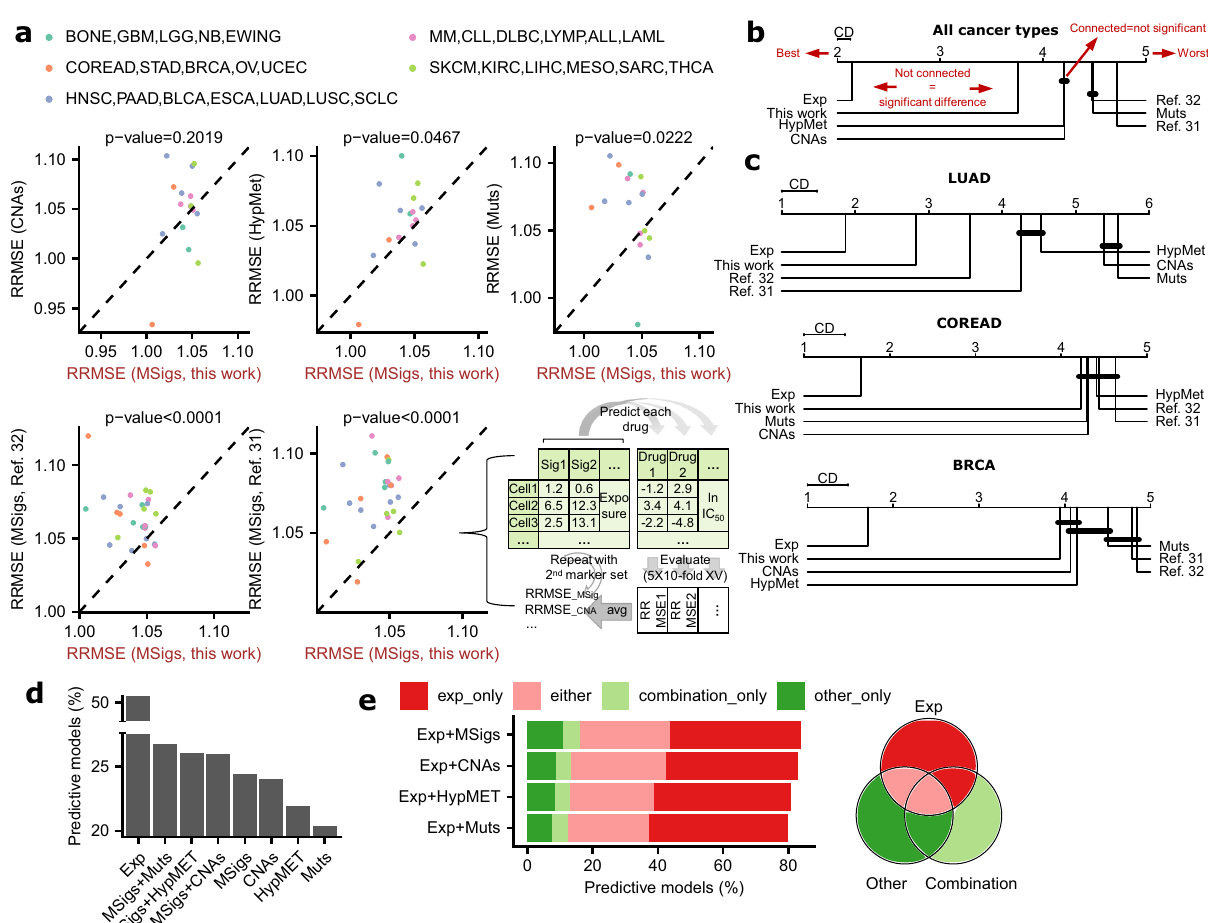
Fig. 2 Prediction of drug response with mutational signatures and other molecular data types. a Predictive performance (RRMSE, relative root-mean- square error) of drug response prediction with mutational signatures ( “ MSigs") reported here and previously 31,32 and other data types (oncogenic mutations ( “ Mut ” ), copy number alterations ( “ CNAs ” ) and DNA hypermethylation ( “ HypMet ” )). P-values of paired one-sided Wilcoxon signed rank test are reported on the plots. Dashed line denotes the diagonal. Bottom right panel shows a schematic of how RRMSE for each tissue was estimated, where “ Sig ” is mutational signature or other marker (CNA etc.), “ Cell ” is cell line, “ XV ” is crossvalidation, and “ Predict ” implies a Random Forest model. b Average rank diagrams for the performance (RRMSE) of the drug response prediction from various sets of markers, using Random Forest. “ This work ” refers to the mutational signatures inferred here, while “ ref. 31 . ” and “ ref. 32 . ” refers to prior sets of mutational signatures. Each graph shows: the ranking among the different marker sets (those at the left-hand side are the best performing) and the signi fi cant differences between pairs of marker sets (if their ranks are at least critical distance (CD) apart, the difference in predictive performance is statistically signi fi cant at p < 0.05, by the Nemenyi post-hoc test, two-sided). The groups of marker sets for which there is no signi fi cant difference are connected by black lines. c Tests shown separately for four tissues-of-origin with the highest number of cell lines in our panels. d The percentage of the Random Forest models that are predictive of drug response, de fi ned as having a predictive error lower than the one of an uninformative default model (predicts the average log IC50 for every cell line). Expressed relative to the total number of testable drug-tissue pairs. e The percentage of models that are predictive with gene expression but not another feature type ( “ exp_only ” ), by other feature type but not with gene expression ( “ other_only ” ), by either model ( “ either ” ), or only by a combination of both ( “ combination ” ). Source data are provided as a Source Data fi